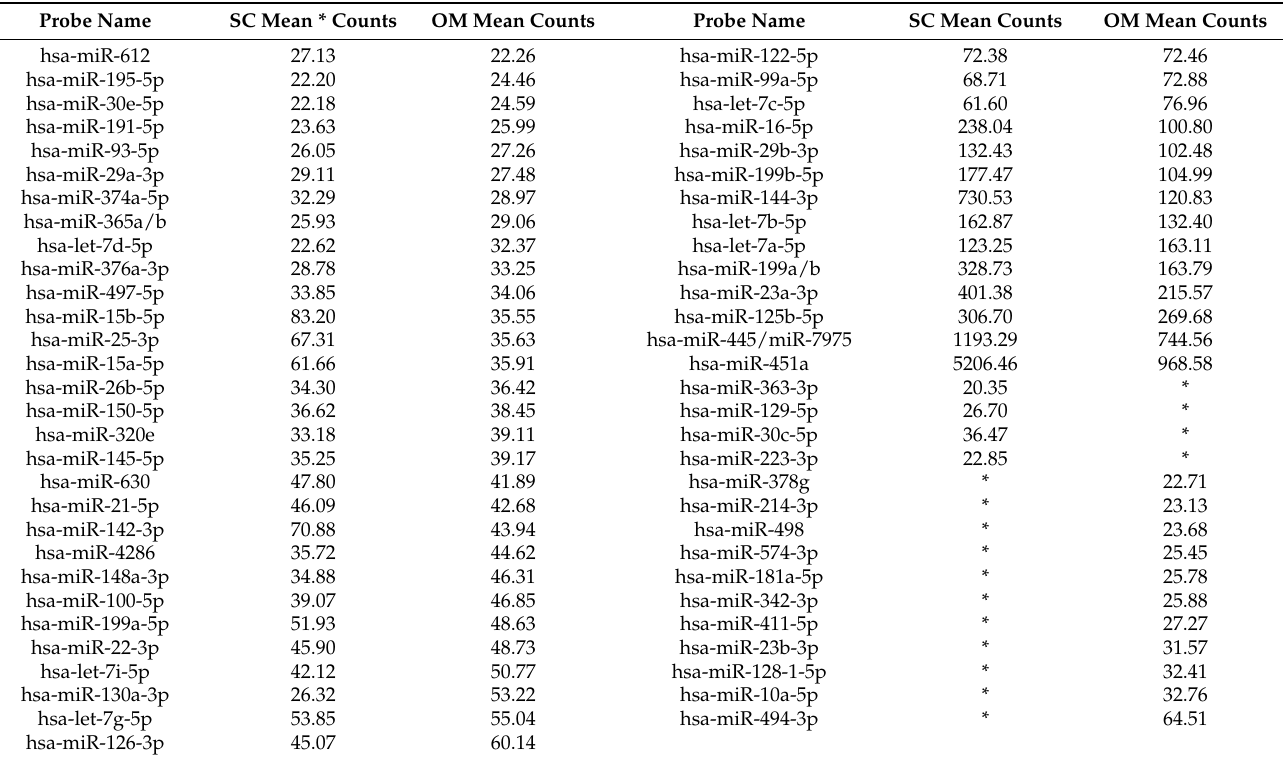
* Mean values represent normalized data from three biological